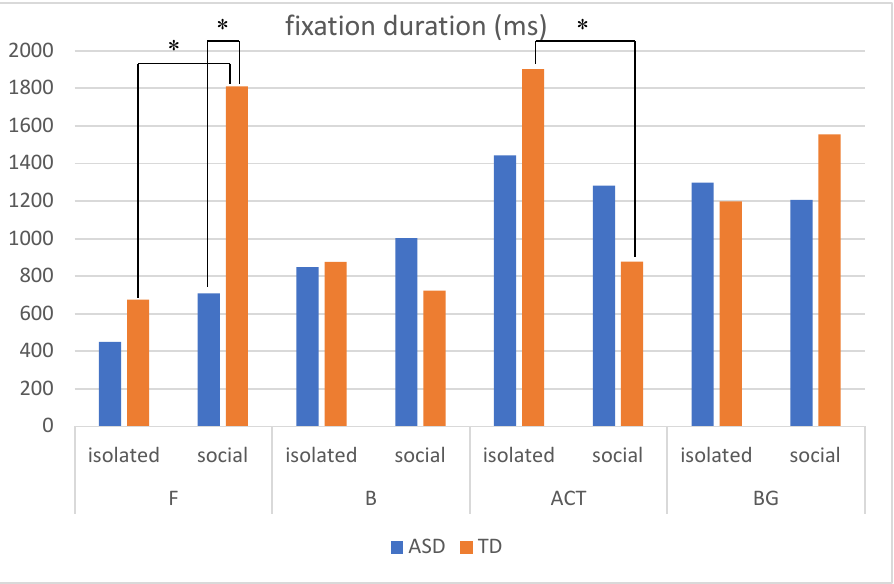
Figure 6. Fixation duration of autistic children and TD children in different scenes (* indicates a significant difference in means using pairwise comparisons, p < 0.05. There is significant difference between two groups in the face AOI in social interaction scene. There is no significant difference between the fixation duration of each AOI in different social scenes of autistic children. TD children has significant differences in the fixation duration of different social scenes in both the face AOI and activity AOI).